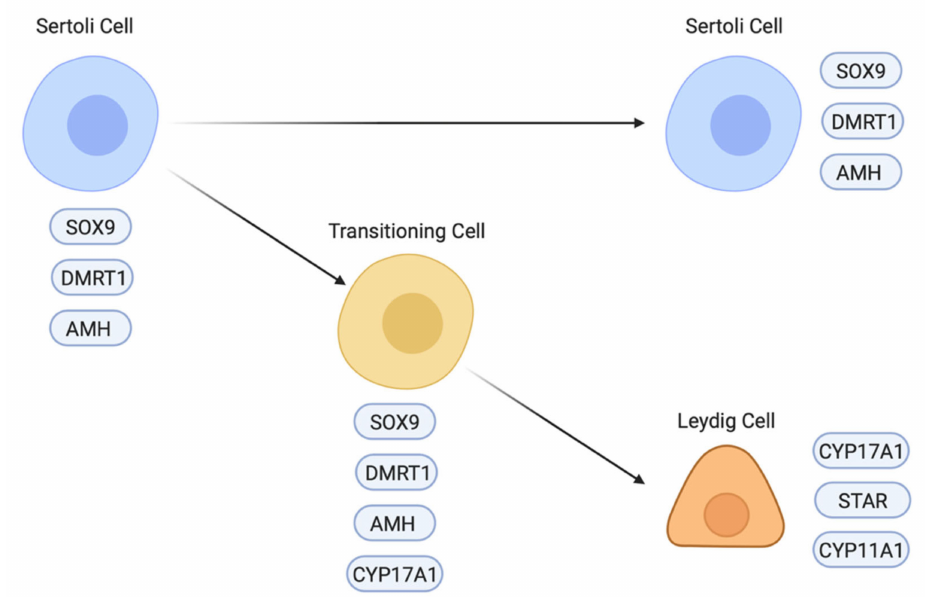
Figure 6. Leydig cells likely derive from a subpopulation of Sertoli cells in the chicken embryo. Some of the differentiated Sertoli cells (expressing SOX9 , DMRT1 and AMH ) start expressing the steroidogenic gene CYP17A1 and start transitioning into a steroidogenic cell type. These transitioning cells express both Sertoli and Leydig cell markers. In order to differentiate into Leydig cells, the Sertoli cell markers are downregulated and steroidogenic cell markers ( StAR and CYP11A1 , etc.) are upregulated. Image created with